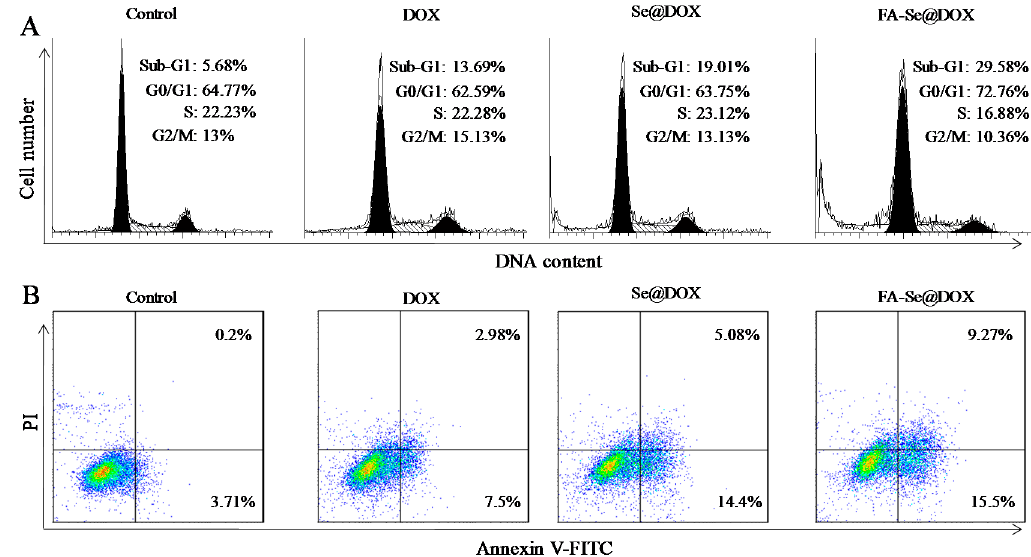
Figure 6. ( A ) Representative flow cytometry histograms of the cell cycle analysis of HeLa cells after incubation with various formulations of DOX for 24 h. ( B ) The apoptosis percentages analysis of HeLa cells after incubation with various formulations of DOX for 24 h.